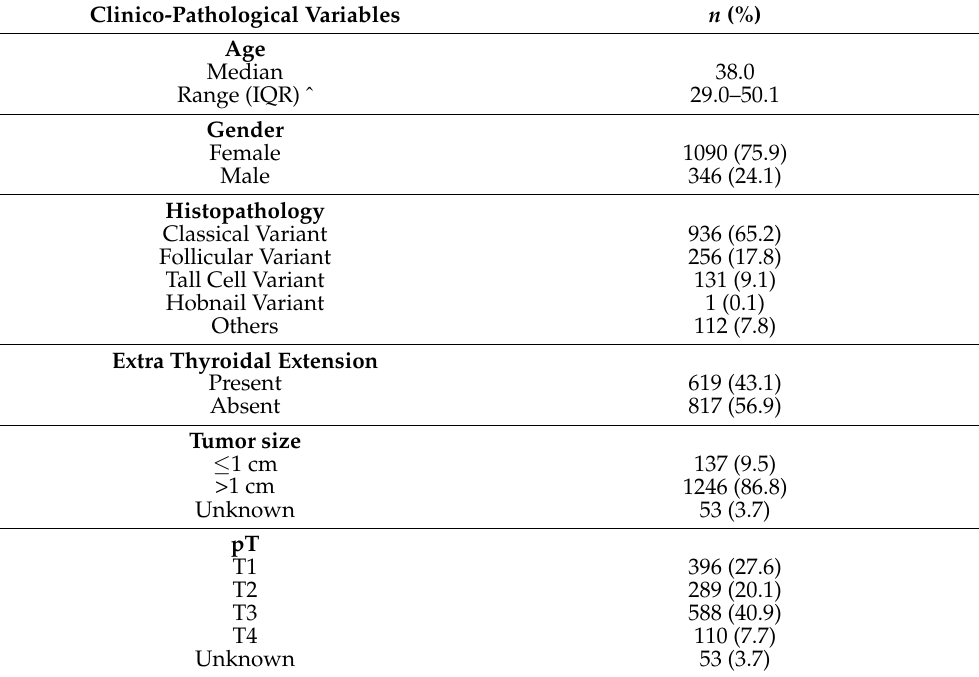
Table 1. Clinicopathological variables for the patient cohort ( n =